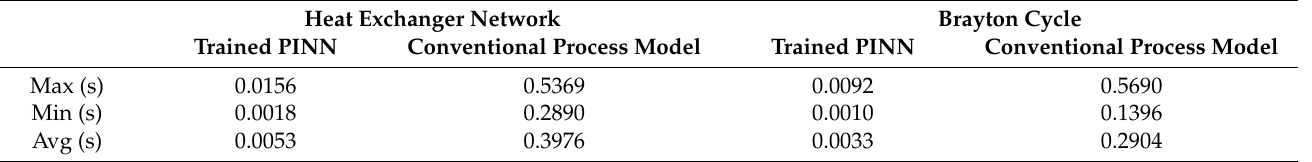
Table 11. Time taken to generate a